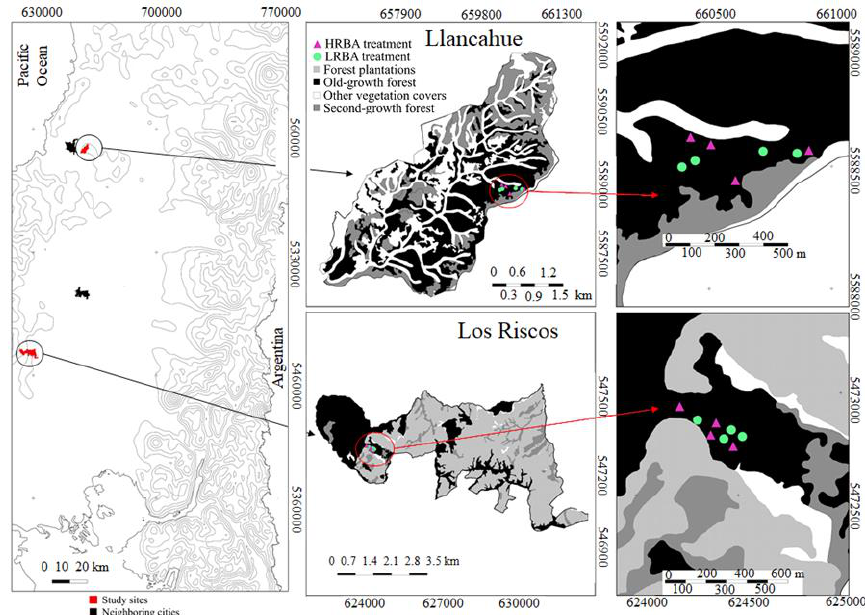
Figure 1. Location of the study sites and the position of the high residual basal area (HRBA, n = 8) and low residual basal area (LRBA, n = 8) plots at the two